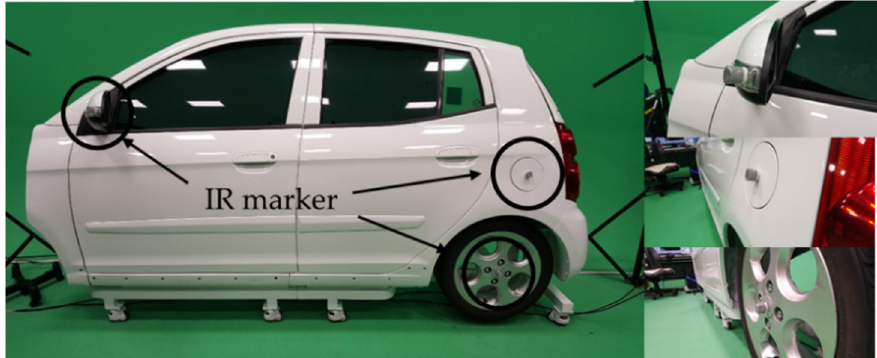
tion and a calibrated marker position in the world coordinate, respectively, for the 𝑖 -th marker after